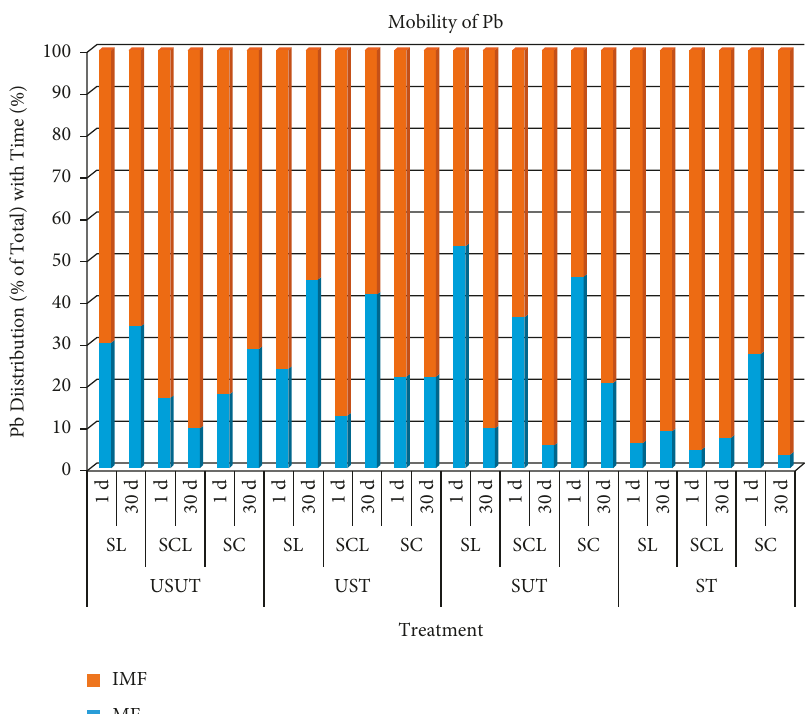
Figure 4: Changes in mobile and immobile fractions of lead in three soils with time; SL - silt loam soil, SCL - silty clay loam soil, SC - silty clay soil, USUT- unspiked untreated, UST- unspiked treated with OM, SUT- spiked untreated with OM, ST- spiked treated with OM, MF- mobile fractions, IMF- immobile